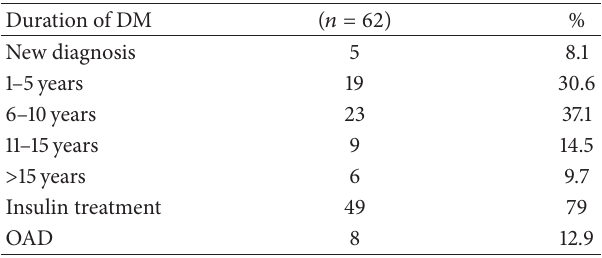
Table 2: Duration and treatment of diabetes mellitus in patients with type 2 diabetes without clinical